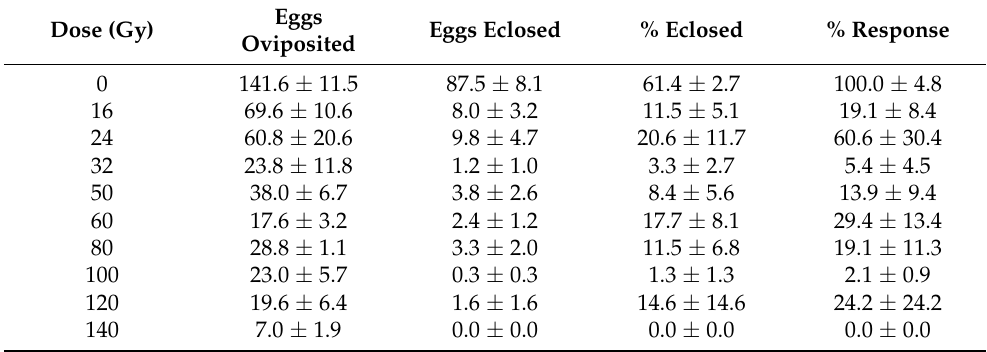
Table A3. Fecundity and fertility values (mean ± s.e.) of Bagrada hilaris in treatment 3 (IM/IF: irradiated male × irradiated female) at different irradiation